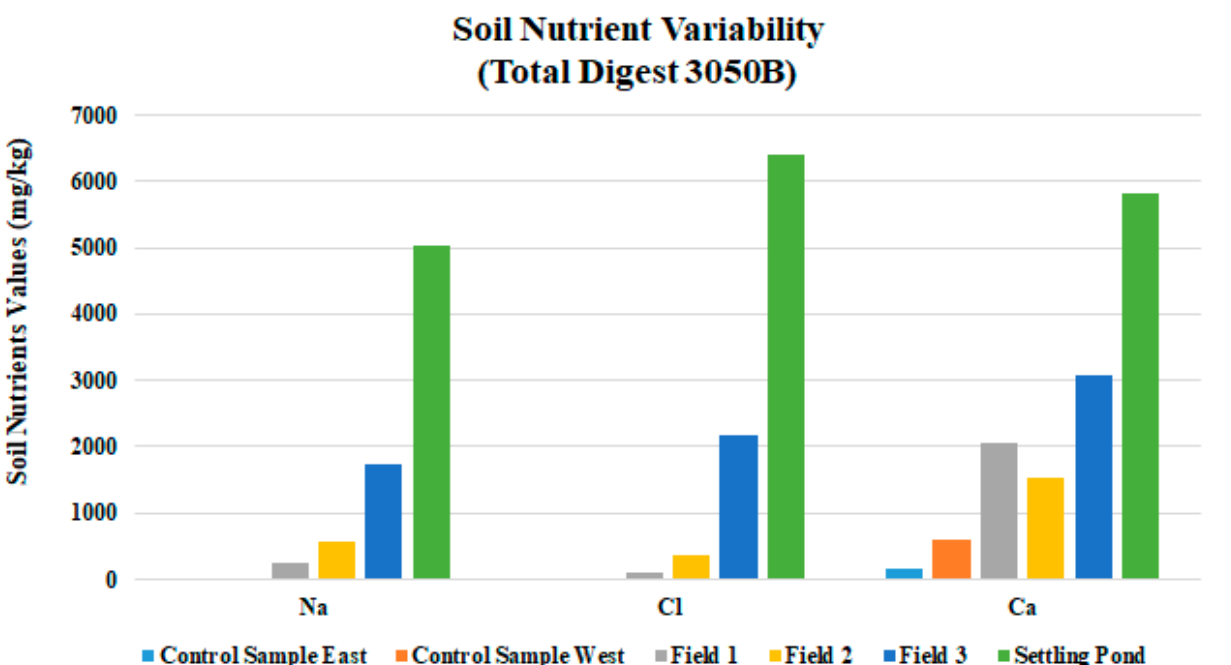
Figure 5. Mean sodium (Na), chloride (Cl), and calcium (Ca) values for three fields sampled during the study.